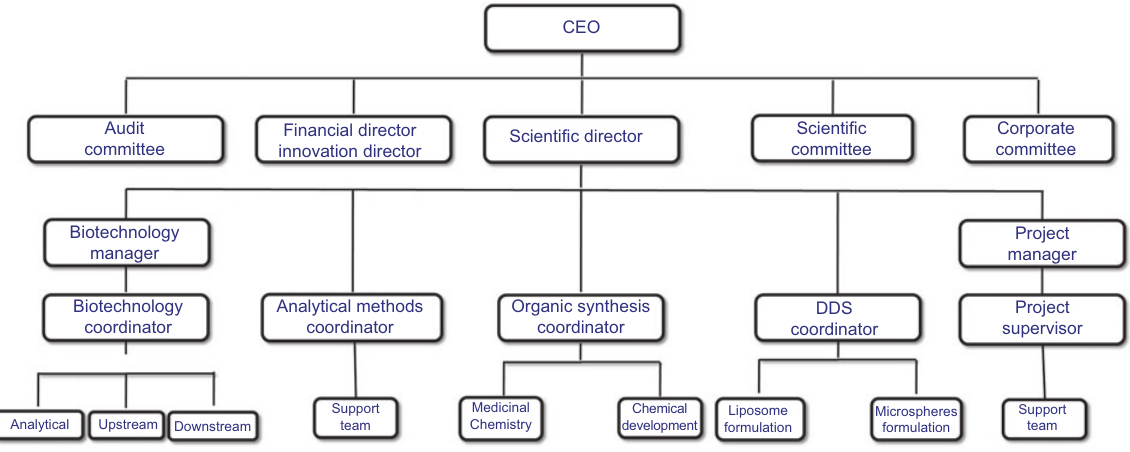
Figure 1 Organization chart of the scientifi c divisions of Vita Nova